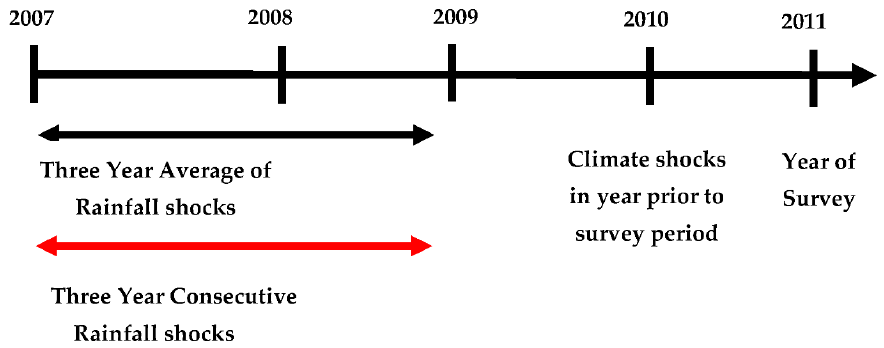
Figure A1. Identification strategy—calculating the three-year average (2007 to 2009) climate shocks while controlling for climate shocks in the year before the survey period.